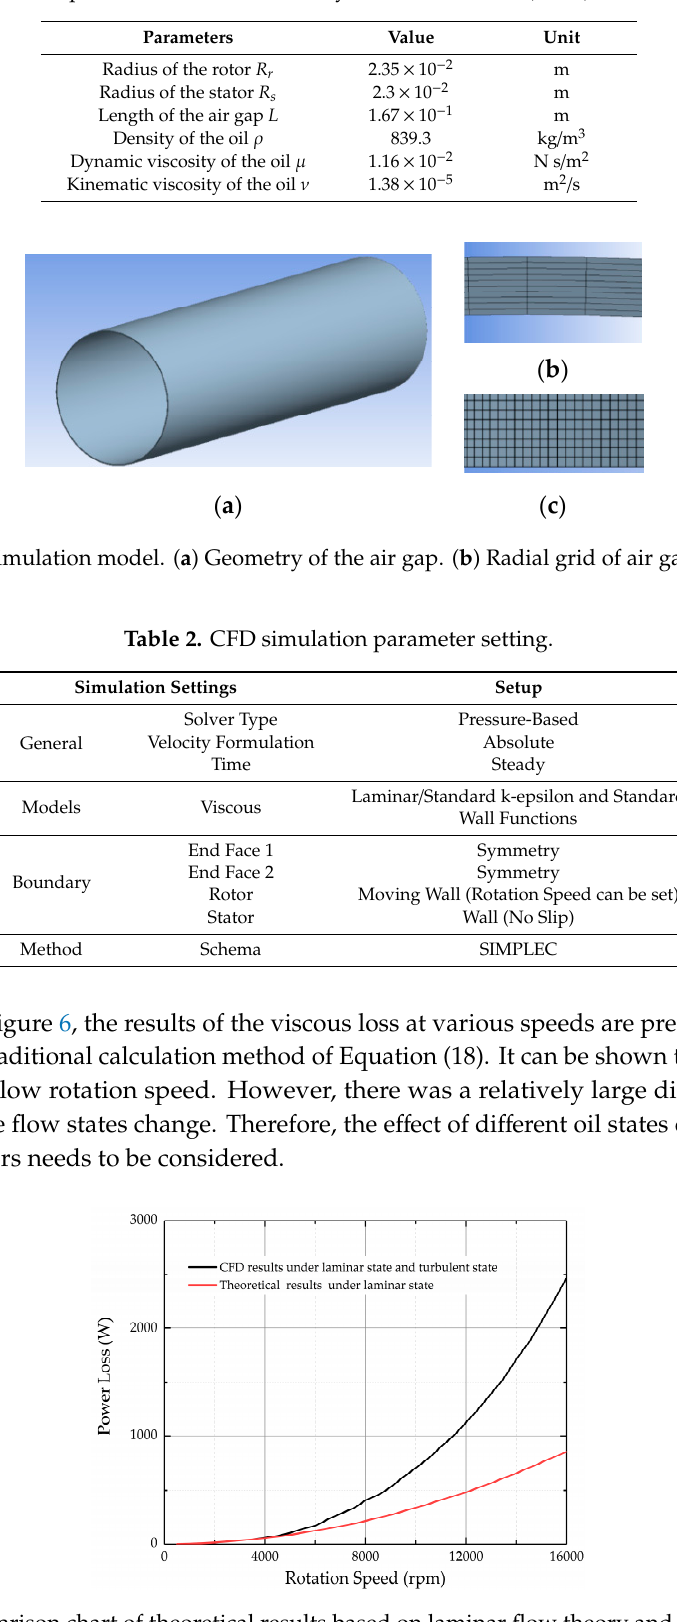
Figure 7. Comparison chart of theoretical results and CFD simulation results under laminar state and turbulent state.